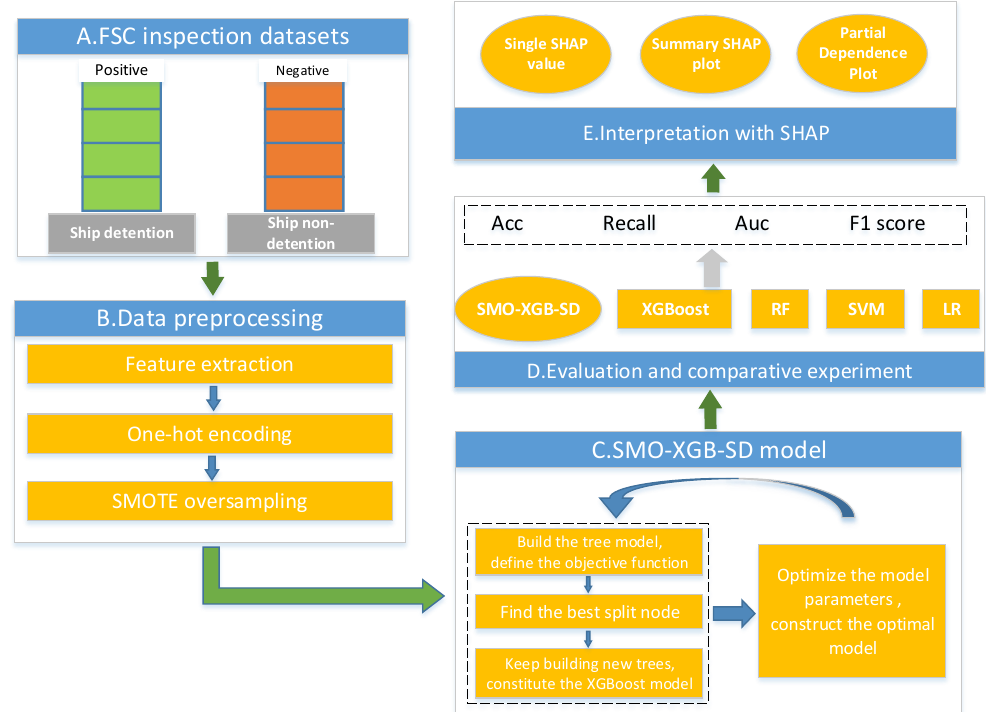
Figure 1. Overall framework of the ship detention decision-making model based on machine learning, i.e., the SMO-XGB- SD model.